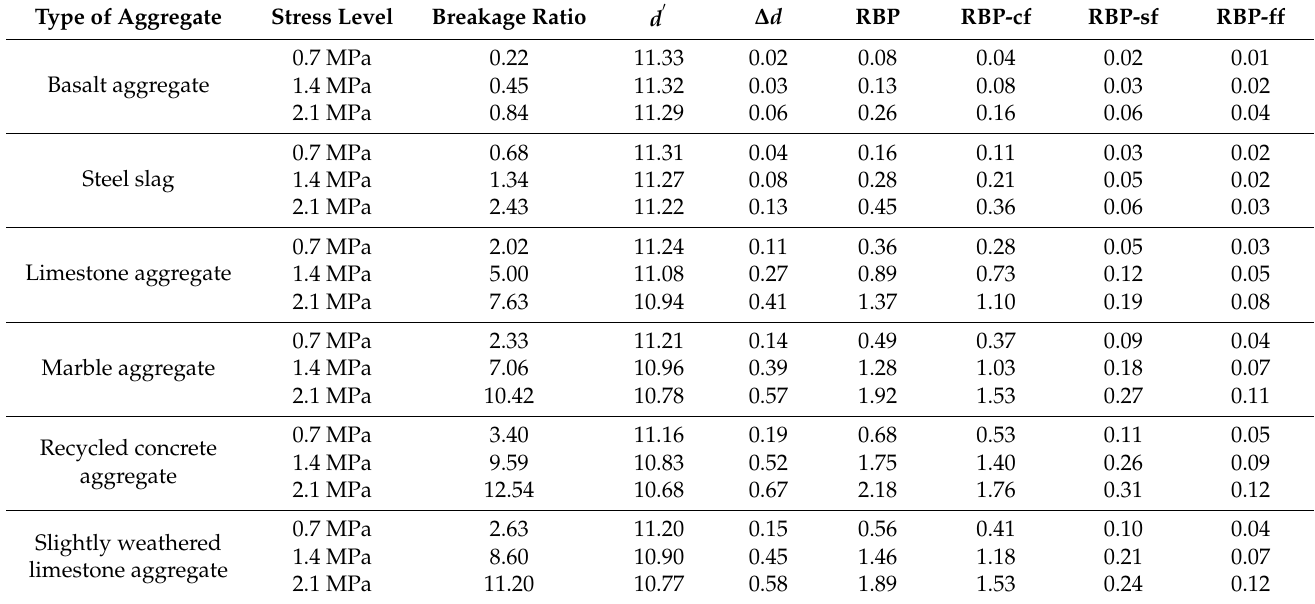
Table 6. Results of aggregate crushing characteristics under dynamic ACVTs.